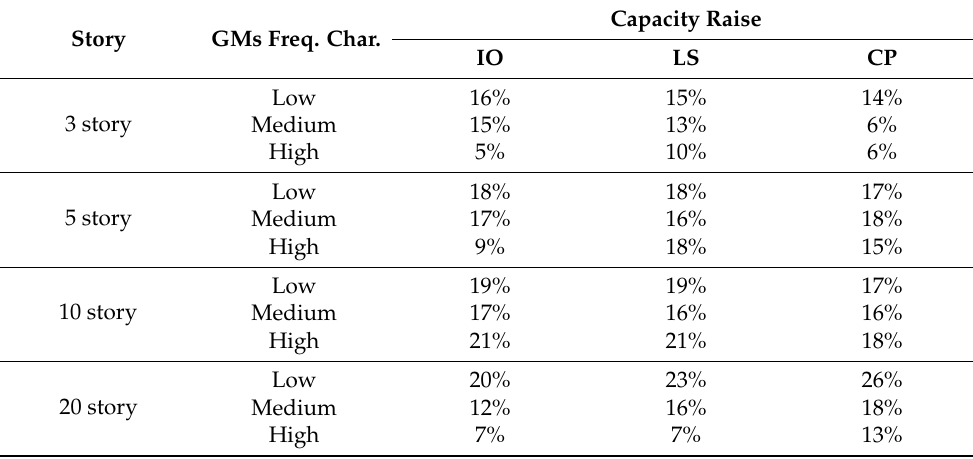
Table 5. Seismic capacity increases due to TMD at mean fragility